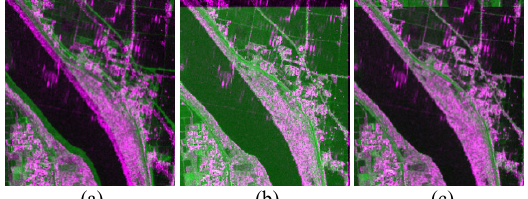
Figure 10. (a) The 301x301 patch with center image coordinates (4561,1361) before matching. Magenta and green represent the SAR and optical images respectively. (b) Patch matched by MI and computed translations: (-4.06, 10.4) (c) Patch matched by FTCC and computed translations: (-3.64,